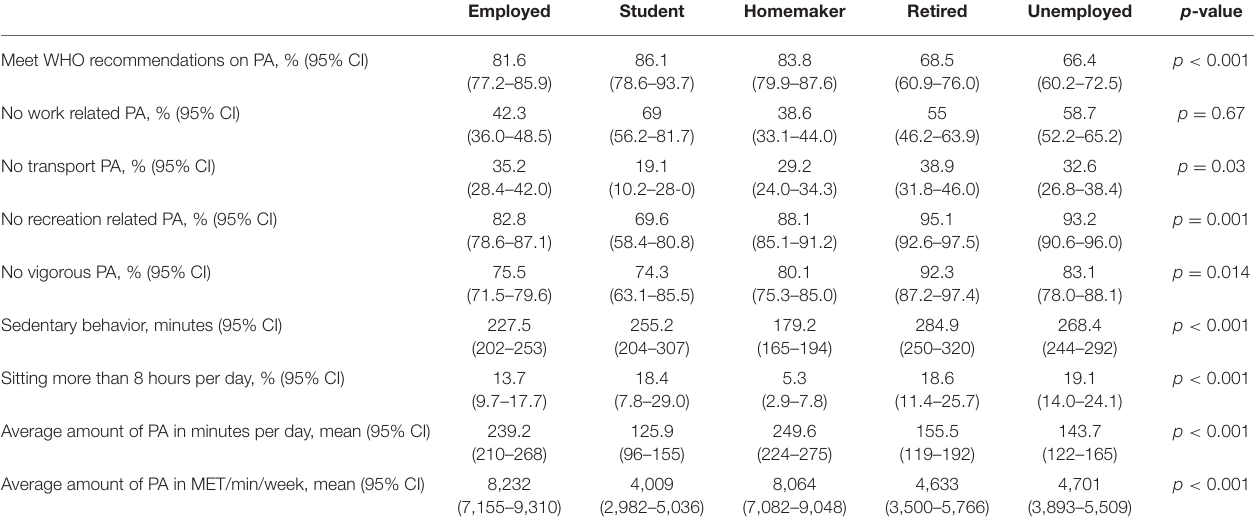
TABLE 6 | Indicators of physical activity and sedentary behavior for different occupation groups. Employed Student Homemaker